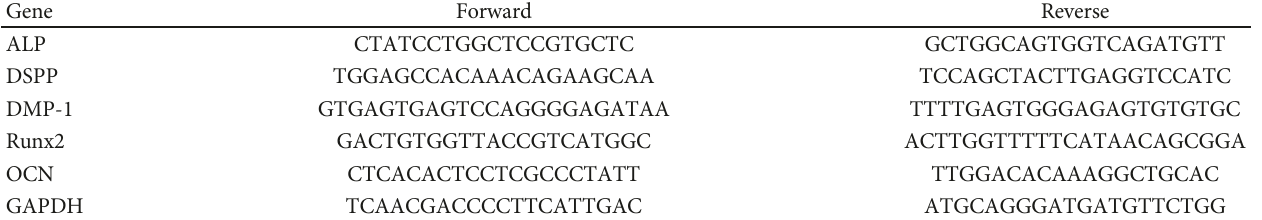
Table 1: List of reverse transcriptase polymerase chain reaction primers.